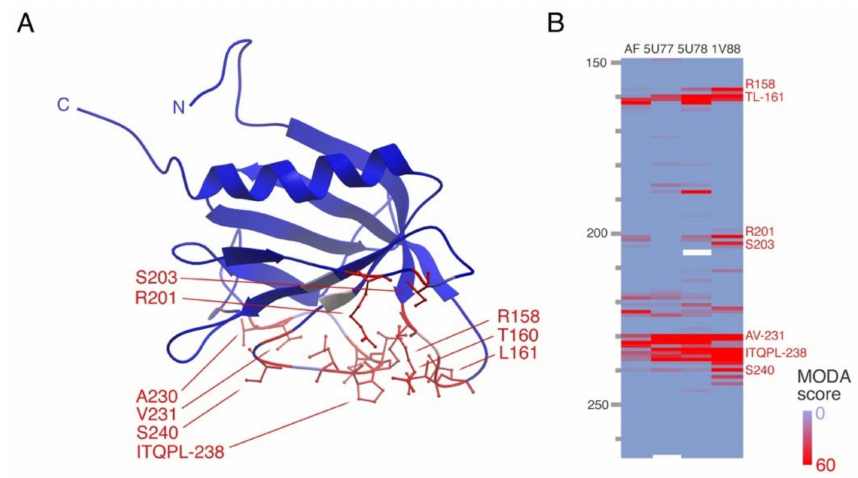
Figure 5. Structures and membrane binding surface of the ORP8 PH domain. ( A ) The structure (PDB: 1V88), which was determined by NMR by S. Yokoyama’s group, is shown with the residues showing significant phospholipid bilayer binding propensities indicated in red, along with sidechains for those forming the major membrane binding surface. The N- and C-termini are labelled. ( B ) The heatmap shows residues in shades of red for significant membrane binding propensities in the AlphaFold2 model, NMR and crystal structures, with the remainder in blue, based on the inset gradient. White cells represent unresolved residues in the